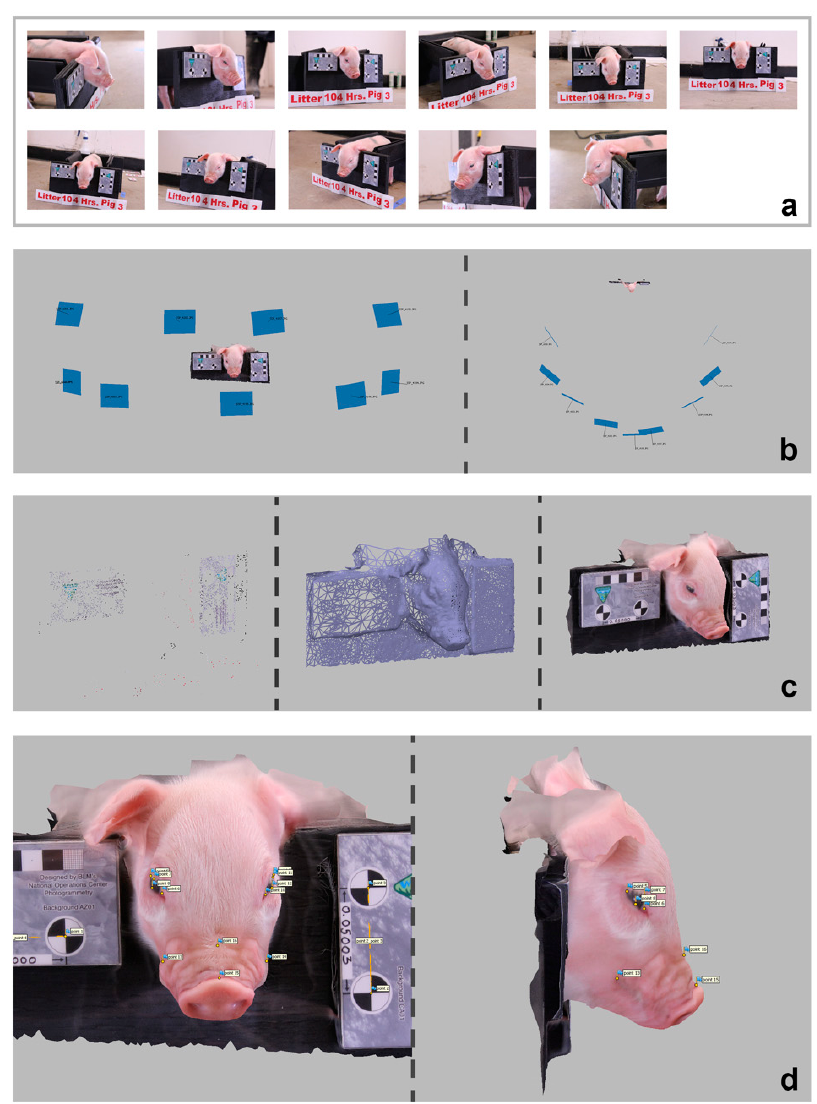
Figure 2. Model Processing in Agisoft Metashape (pig in Litter 10 at 4 h post-castration as example): ( a ) Set of 11 images input into Metashape; ( b ) Set of 9 images successfully aligned in 3D space by Metashape as represented by blue rectangles viewed from the front and above; ( c ) From left to right a sparse point cloud, wireframe, and textured (i.e., with 3D photo overlay) model view of a processed piglet model; ( d ) Location of the 16 landmarks, including 4 landmarks for scale on the